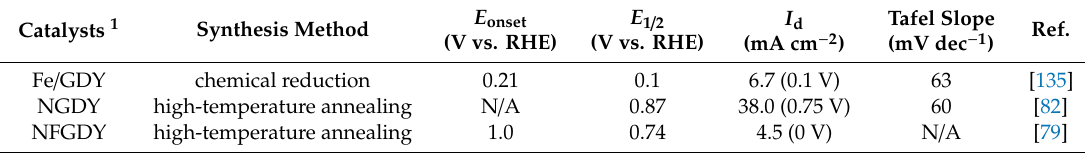
Oxygen reduction reaction (ORR) performance of metal-atom-anchored GDY and nonmetallic-atom-doped